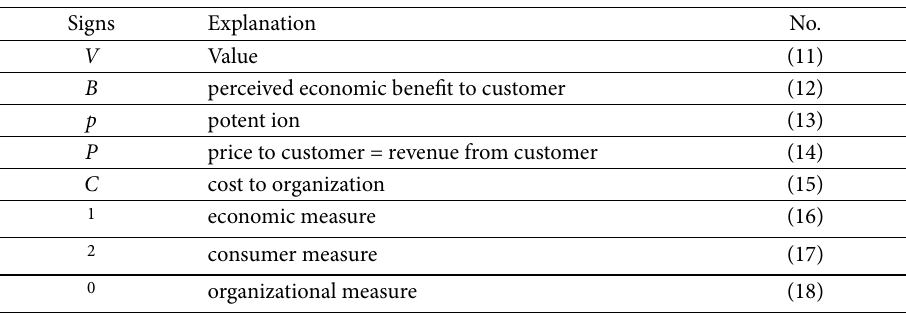
Table 1. Explanation of variables in Eqs